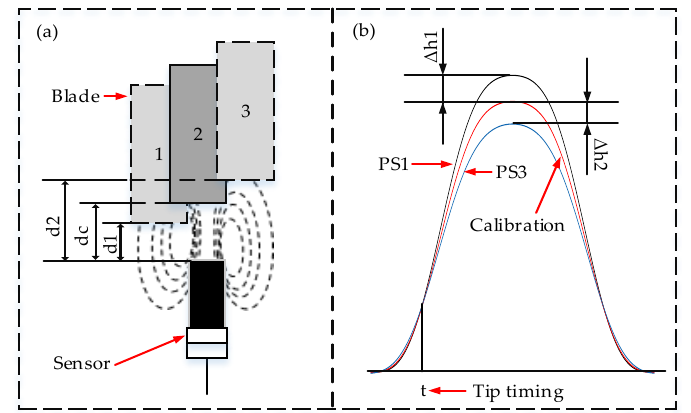
Figure 7. The measurement principle of BTT and tip clearance (TC) signals. ( a ) Schematic diagram of different tip clearances; ( b ) Impulse response signals.